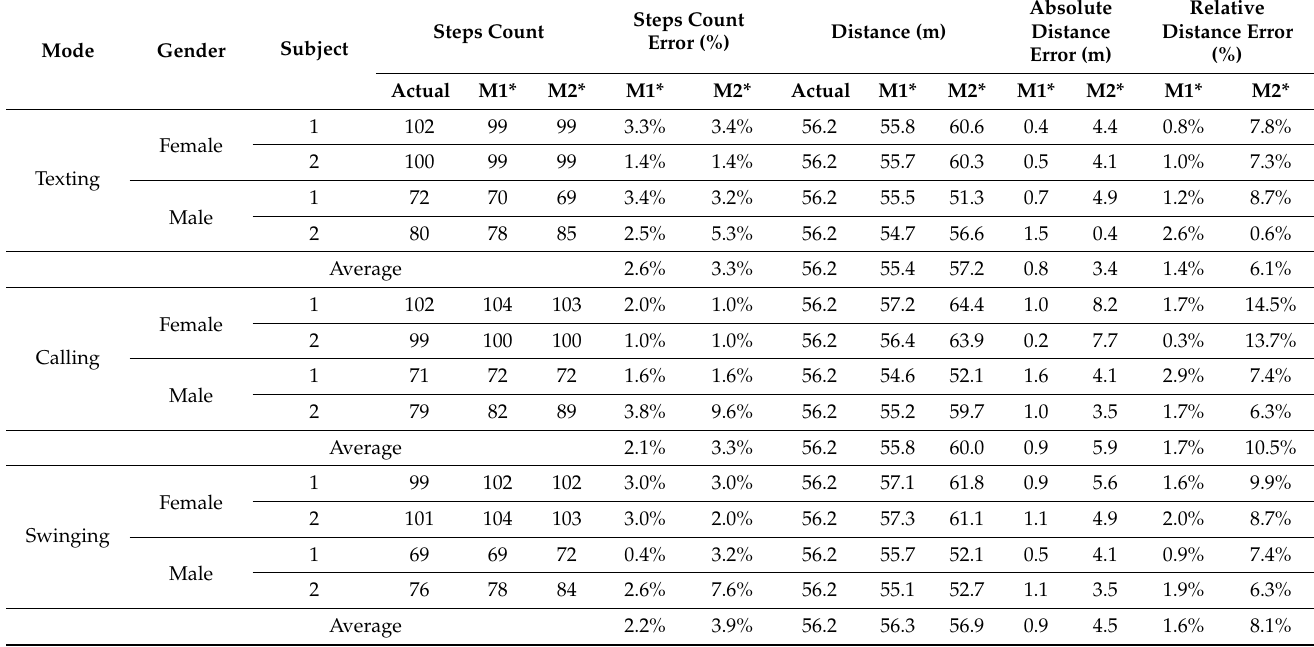
Table 9. Distance estimation on the 3D trajectory.